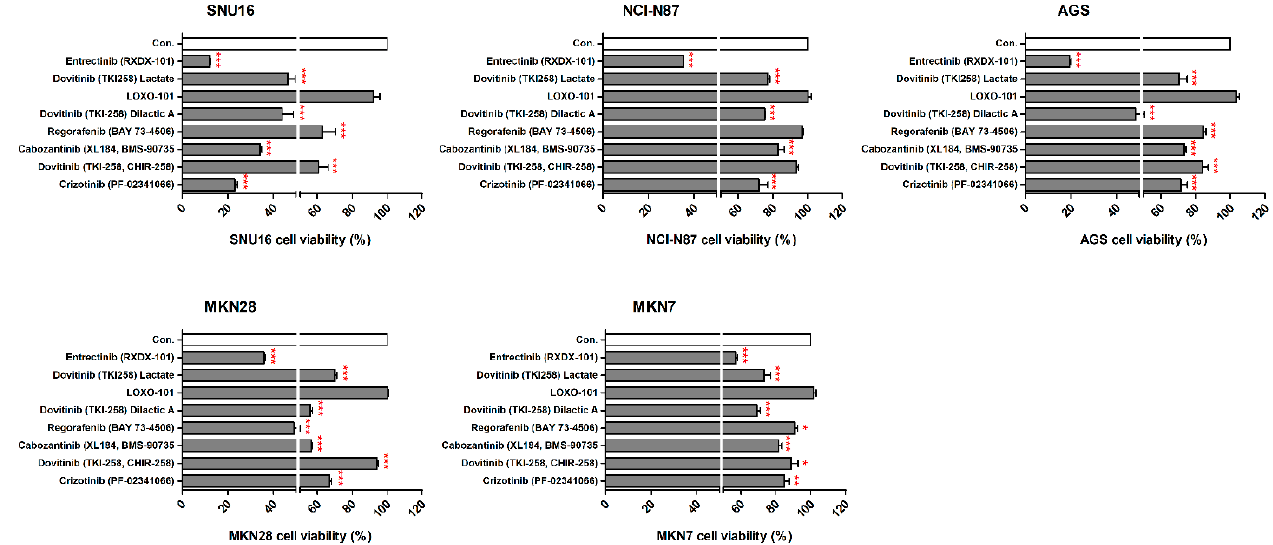
Figure 3. Effects of neurotrophic receptor tyrosine kinase (NTRK) inhibitors on gastric cancer cells with or without NTRK gene and protein expression. SNU16, NCI-N87, AGS, MKN28, and MKN7 cells were treated with 10 μ M concentrations of NTRK inhibitors for 48 h. * p < 0.05. ** p < 0.01 and *** p < 0.001 compared with control group.